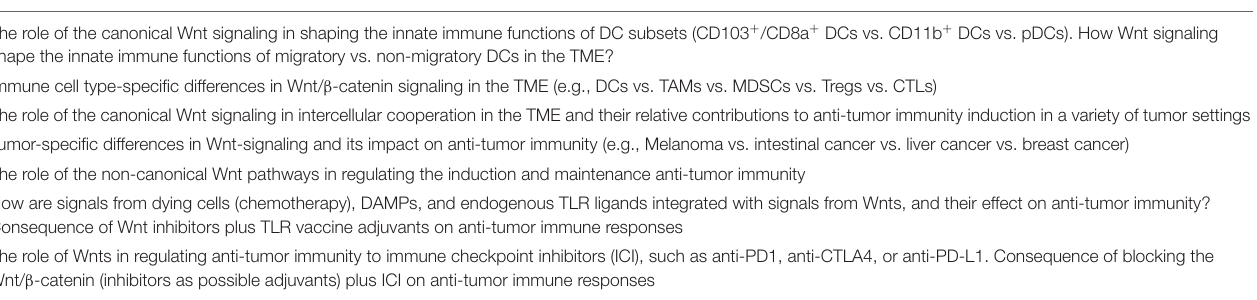
TABLE 2 | Some knowledge gaps in understanding how Wnts regulate anti-tumor immunity. The role of the canonical Wnt signaling in shaping the innate immune functions of DC subsets (CD103 + /CD8a + DCs vs. CD11b + DCs vs. pDCs). How Wnt signaling shape the innate immune functions of migratory vs. non-migratory DCs in the TME? Immune cell type-specific differences in Wnt/ β -catenin signaling in the TME (e.g., DCs vs. TAMs vs. MDSCs vs. Tregs vs. CTLs) The role of the canonical Wnt signaling in intercellular cooperation in the TME and their relative contributions to anti-tumor immunity induction in a variety of tumor settings Tumor-specific differences in Wnt-signaling and its impact on anti-tumor immunity (e.g., Melanoma vs. intestinal cancer vs. liver cancer vs. breast cancer) The role of the non-canonical Wnt pathways in regulating the induction and maintenance anti-tumor immunity How are signals from dying cells (chemotherapy), DAMPs, and endogenous TLR ligands integrated with signals from Wnts, and their effect on anti-tumor immunity? Consequence of Wnt inhibitors plus TLR vaccine adjuvants on anti-tumor immune responses The role of Wnts in regulating anti-tumor immunity to immune checkpoint inhibitors (ICI), such as anti-PD1, anti-CTLA4, or anti-PD-L1. Consequence of blocking the Wnt/ β -catenin (inhibitors as possible adjuvants) plus ICI on anti-tumor immune